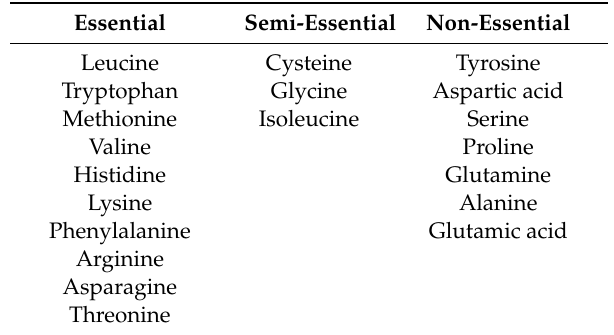
Table 2. Essential, semi-essential and non-essential amino acids required for successful egg production. Data from Attardo et al. [77].